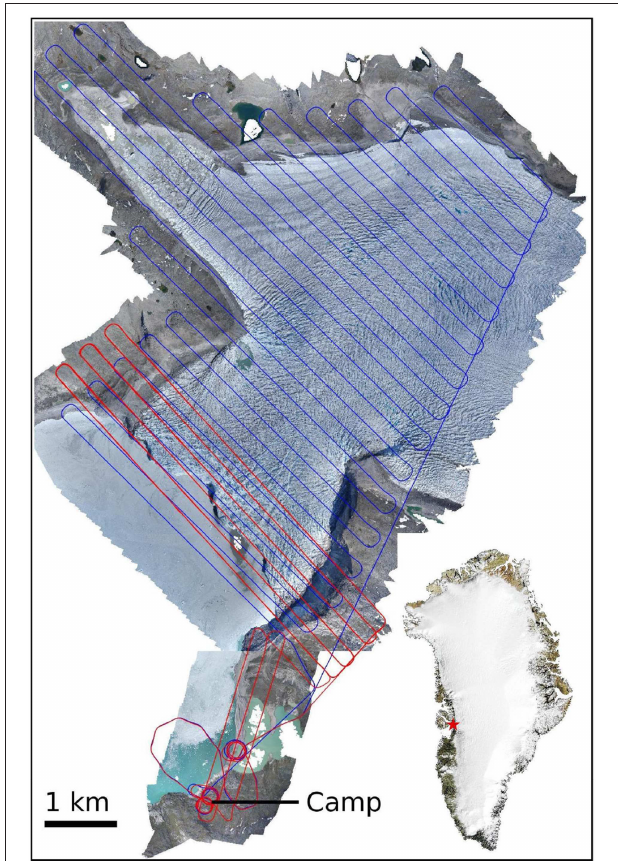
FIGURE 2 | Ortho-image of Eqip Sermia acquired during a UAV survey on July 8. The lines show the trajectory of the UAV during the large-scale (blue) and repeat (red) missions, respectively. The ascending/descending spirals after take-off and before landing are denoted by the circular tracks around the camp. The area next to camp was also surveyed to assess the accuracy of photogrammetrical products in comparison with in situ GCPs. A map of Greenland (Source: MODIS) is displayed in the lower right and the location of Eqip Sermia glacier is indicated by a red star.